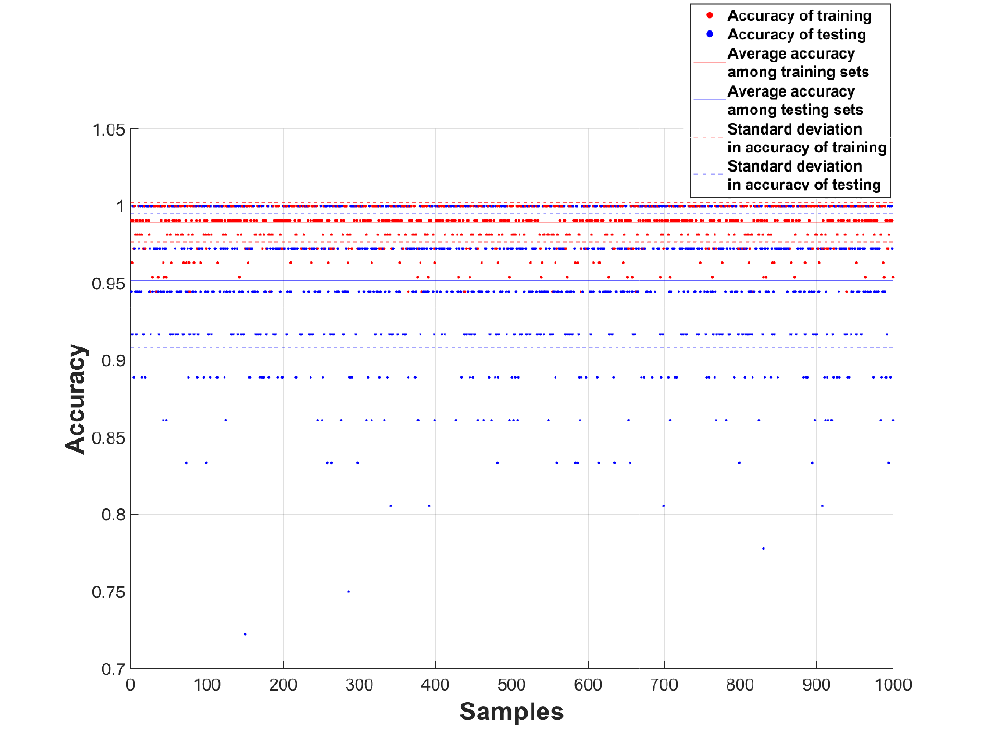
Figure 12. Patterns in the accuracies for 1000 randomized training and testing datasets, as obtained via the DT algorithm backed by a Bayesian